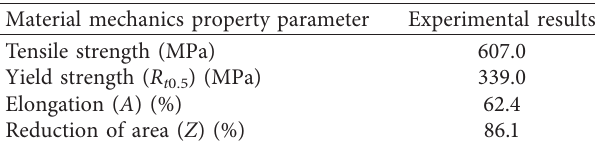
Table 4: Mechanical properties of blank tensile test of 316L stainless steel.